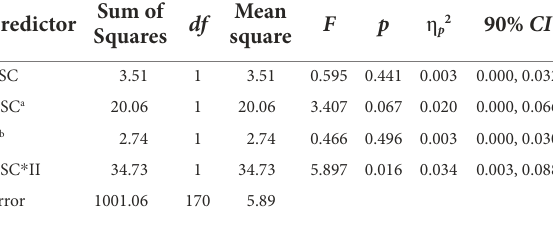
TABLE 1 Study 1: ANCOVA for predicting performance on a self- control task by desire for self-control and implementation intention (controlling for trait